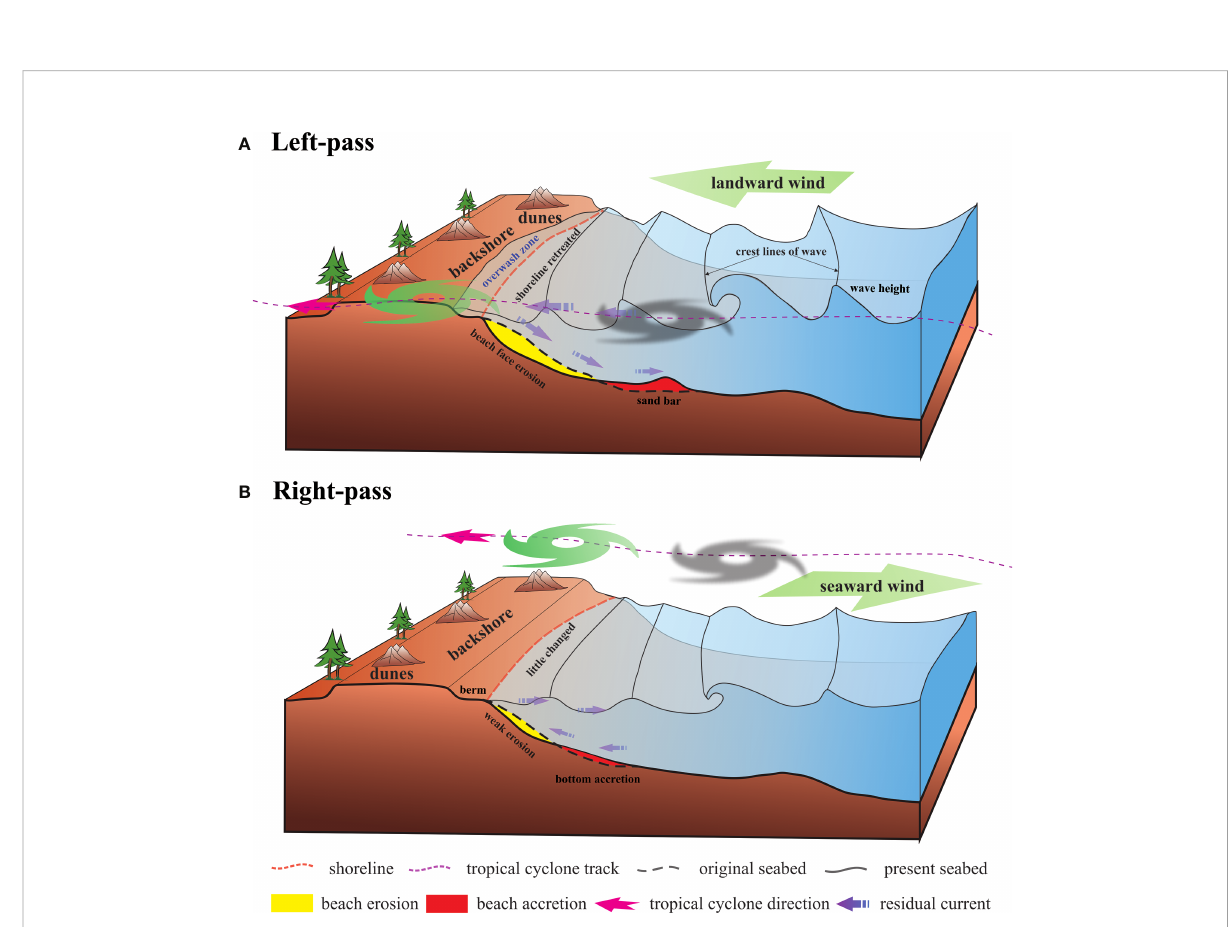
FIGURE 11 Schematic map for the morphologic response of the beach to left-pass (A) and right-pass (B) TCs,